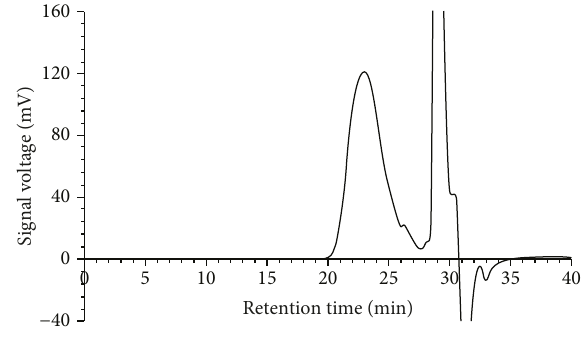
Figure 5: GPC chromatogram of PSEA-2 polyimide.